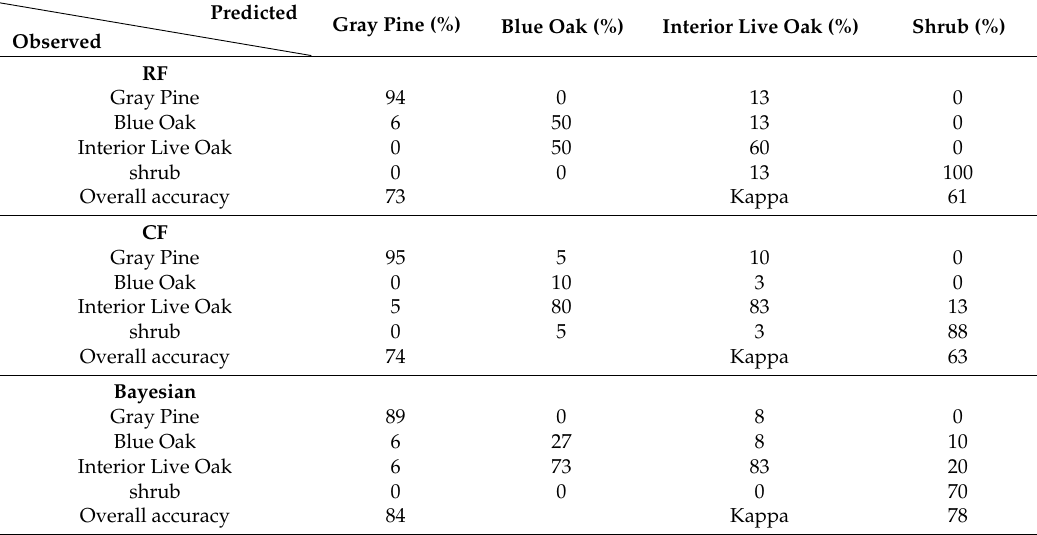
Table 6. Confusion matrix for vegetation classification using RF and CF methods with test data (testing proportion =